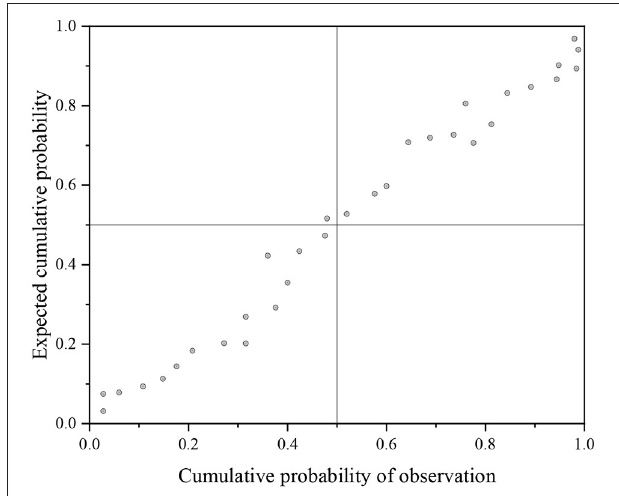
FIGURE 5 | Standard p–p